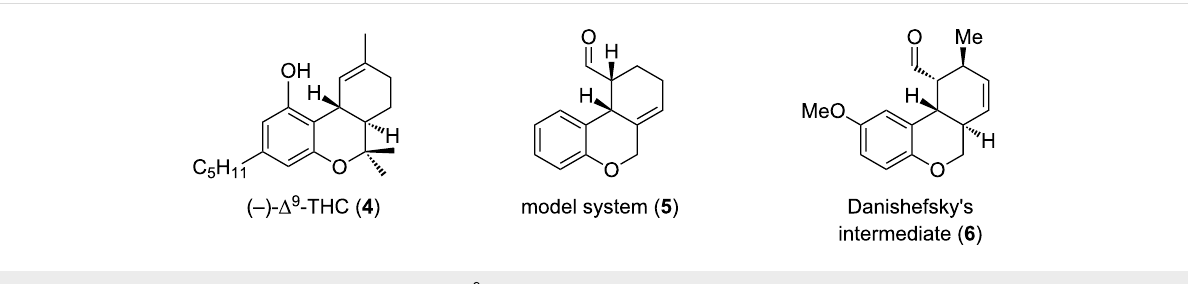
Figure 2: Intermediates towards the total synthesis of ( − )- Δ 9 -tetrahydrocannabinol ( 4 ).